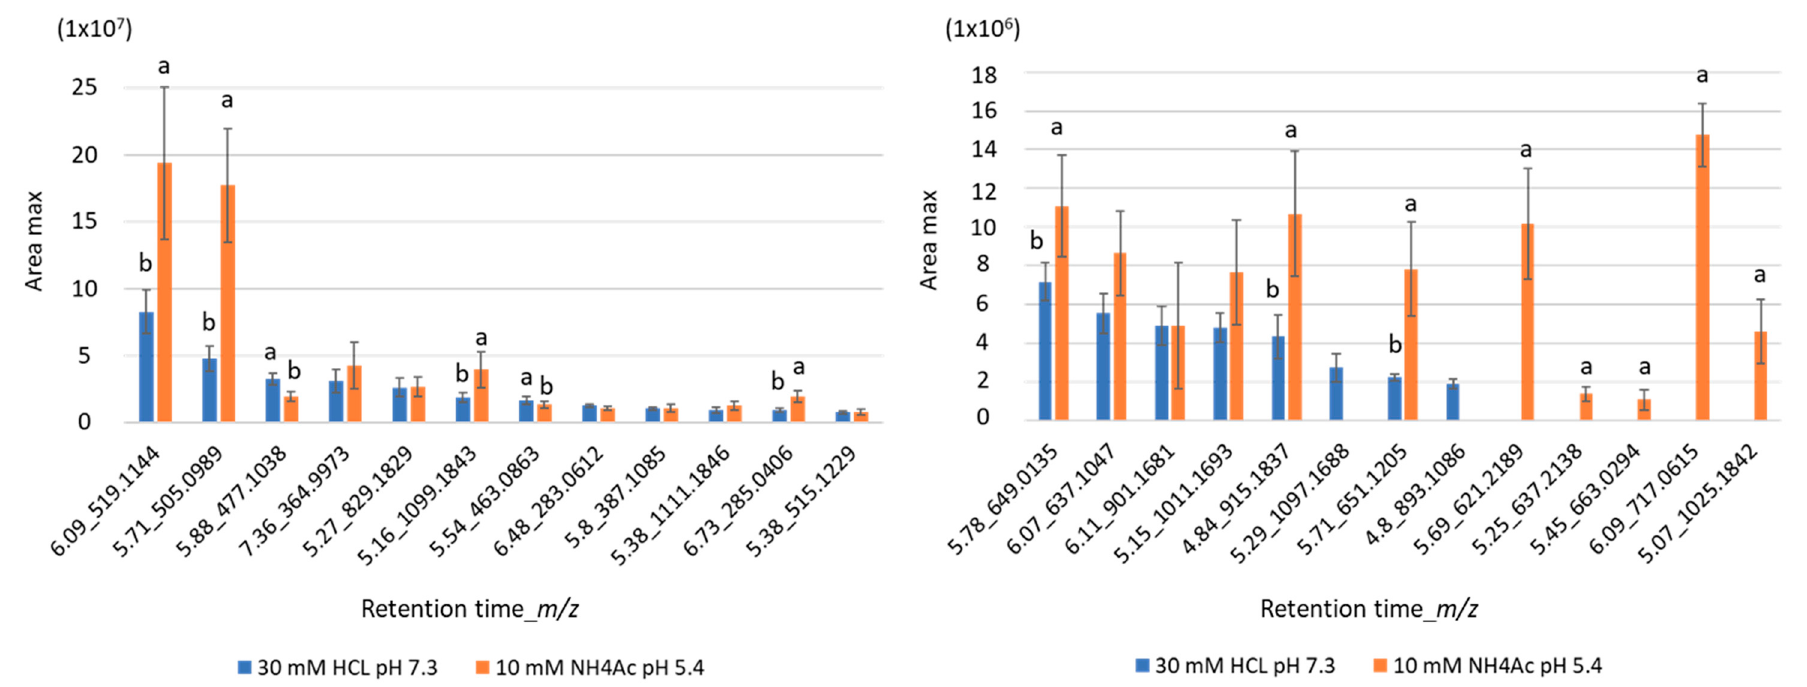
Figure 6. Evaluation of the extraction efficiency of flavonoids (retention time_ m/z ) contained in Salicornia europaea after ultrasound-assisted extraction in NH 4 Ac (30 mM Tris-HCl pH 7 or 10 mM NH 4 Ac pH 5.4). Area peaks are shown as mean ± SD ( n = 3). Lowercase letters indicate statistically significant differences between area peaks observed in both extracts ( t -test, p < 0.05).